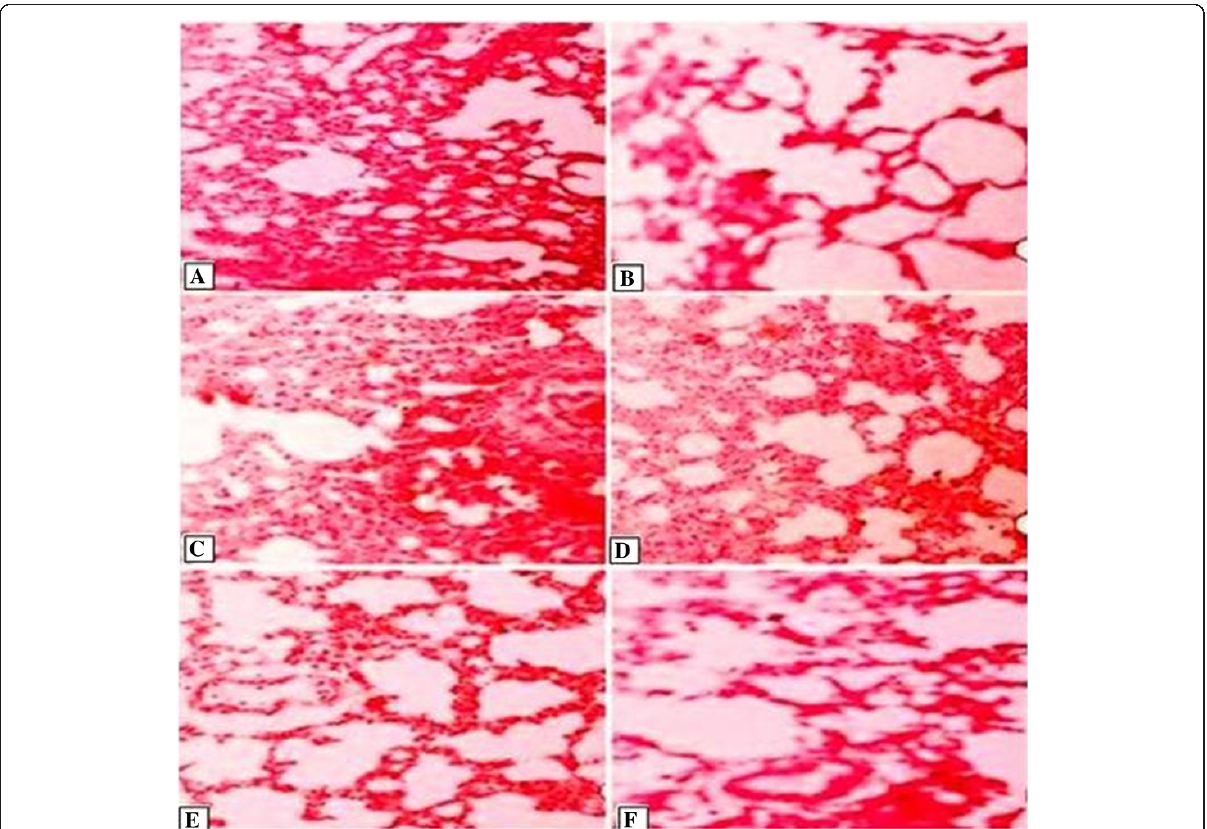
Figure 3 Effect of LME on lung morphology; Slides (from left) Control (A), CCl 4 (B, C), 100 mg/kg LME (D) 200 mg/kg LME (E) 50 mg/kg RT (F). Table 4 Effect of LME on lung morphology Treatment A b Control Olive